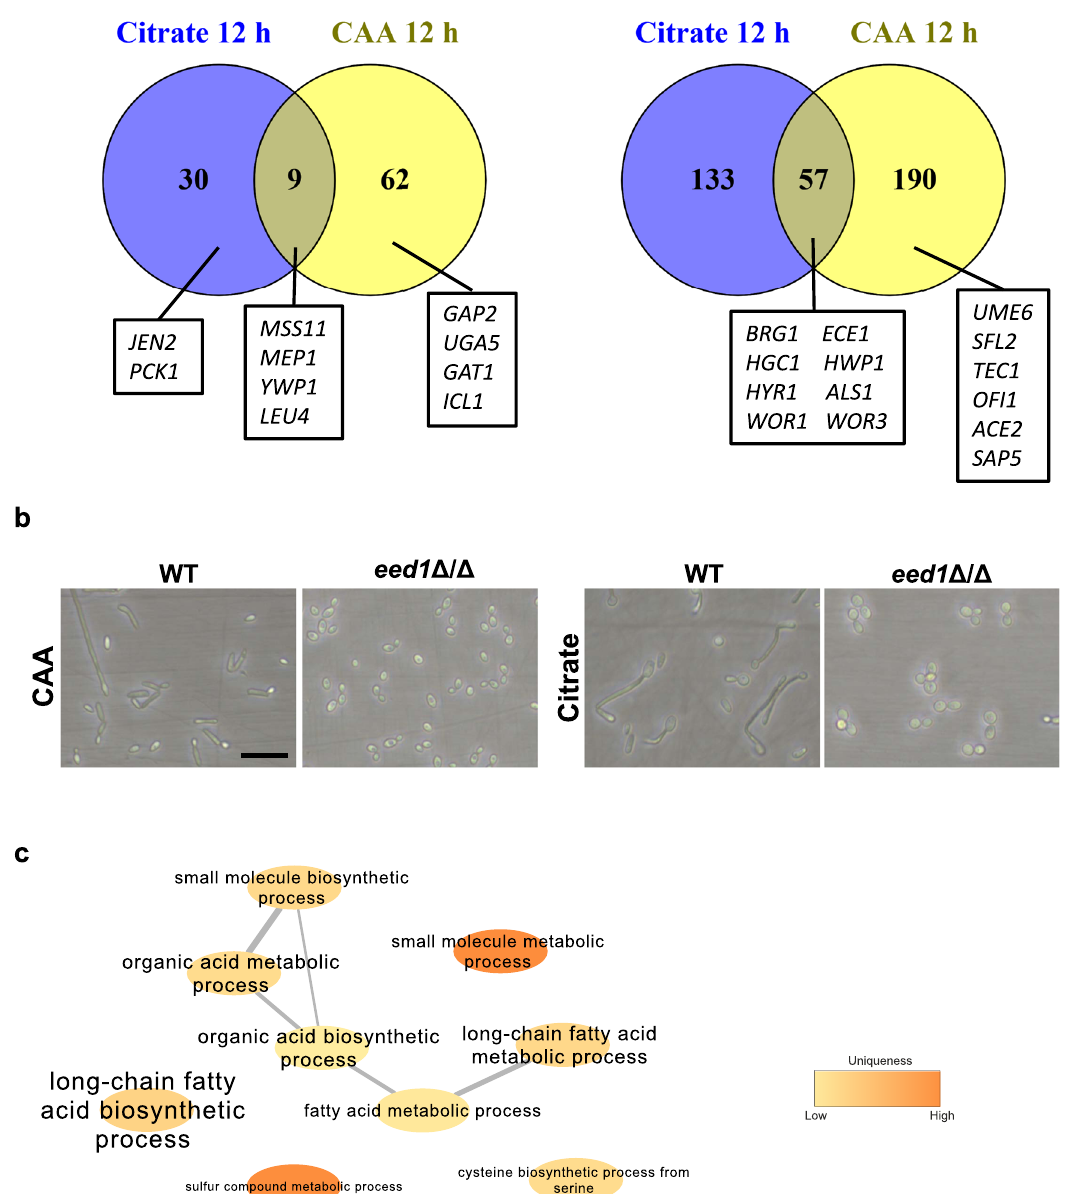
Fig. 7 Transcriptional analysis of the eed1 Δ / Δ mutant during growth on citrate or casamino acids (CAA) after 12 h at 37 °C. a Venn diagrams showing the numbers of genes signi fi cantly up- or down-regulated (±log 2 2 and adjusted p -value <0.05) in the eed1 Δ / Δ mutant compared to WT (SC5314) with citrate or CAA as sole carbon source. Genes referred to in the text are highlighted. b Morphology of C. albicans WT and eed1 Δ / Δ mutant after 12 h of growth on citrate or CAA. Representative pictures from three biologically independent experiments are shown. Scale bar represents 20 µ m and applies to all images. c Network analysis of Gene Ontology (GO) term enrichments of signi fi cantly up-regulated genes ( + log 2 2 and adjusted p -value <0.05) in eed1 Δ / Δ mutant compared to WT after 12 h of growth on citrate. Font size represents the p -value ( p < 0.1) of the GO term: big letters – small p value, ranging from p < 2.3 × 10 − 5 to low p -value p < 0.09 indicated by small letters. Color is representing the uniqueness, indicating how particular each term is with respect to the set of terms being evaluated (original data analyzed are available in Supplementary Data